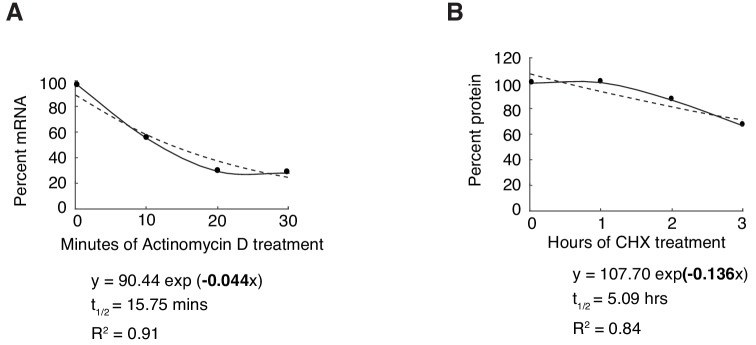
Measurement of sens mRNA and protein decay in the wing disc.(A) Developing wing discs were treated with Actinomycin D to block mRNA synthesis. sens mRNA was measured at 10 min time intervals by RT-qPCR, and an exponential decay rate was estimated from multiple time points. Dashed line shows the fitted decay curve. (B) Developing wing discs were treated with cycloheximide (CHX) to block protein synthesis. Sens protein was measured at 1 hr time intervals by indirect enzyme linked immunosorbent assay (ELISA), and an exponential decay rate was estimated from multiple time points. Dashed line shows the fitted decay curve.